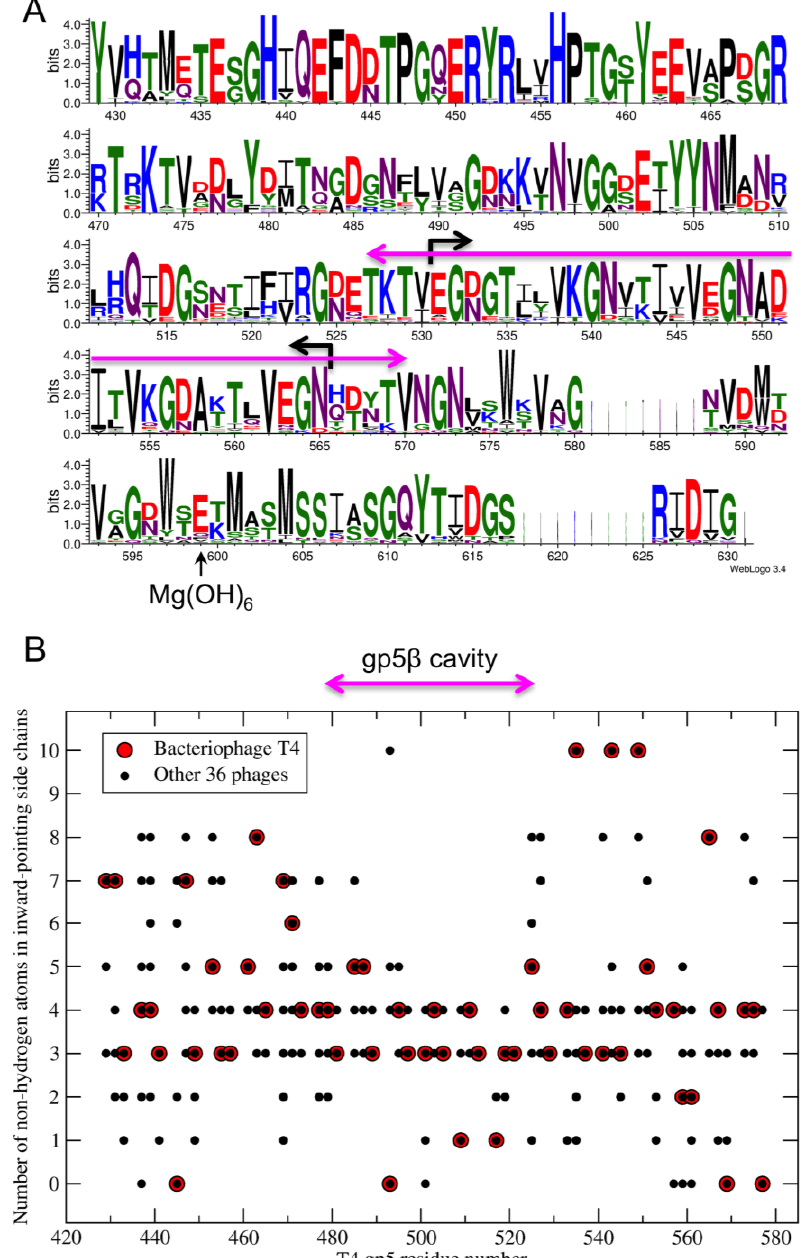
Figure 13. Sequence conservation analysis of gp5 β -helix. ( A ) Sequence conservation of gp5-like β -helices is shown with the help of the WebLogo program [58] in which the height of the letter is proportional to the degree of conservation in this position. The purple arrow corresponds to the cavity in gp5. The black arrows show the borders of the gp5 β -B fragment; ( B ) The size of inward-pointing side chains in gp5-like β -helices is evaluated as a number of non-hydrogen atoms. The same alignment, which was calculated with the help of ClustalW program [59], was used in both panels. Gene IDs are given in Materials and Methods. Our data also demonstrate that heat-induced unfolding of the β -helix in the presence of guanidinium is irreversible. This suggests that fatty acids (and possibly the buried Mg 2+ ion) could be required for folding. Guanidinium is likely to inhibit the interactions of the protein chains with fatty acids